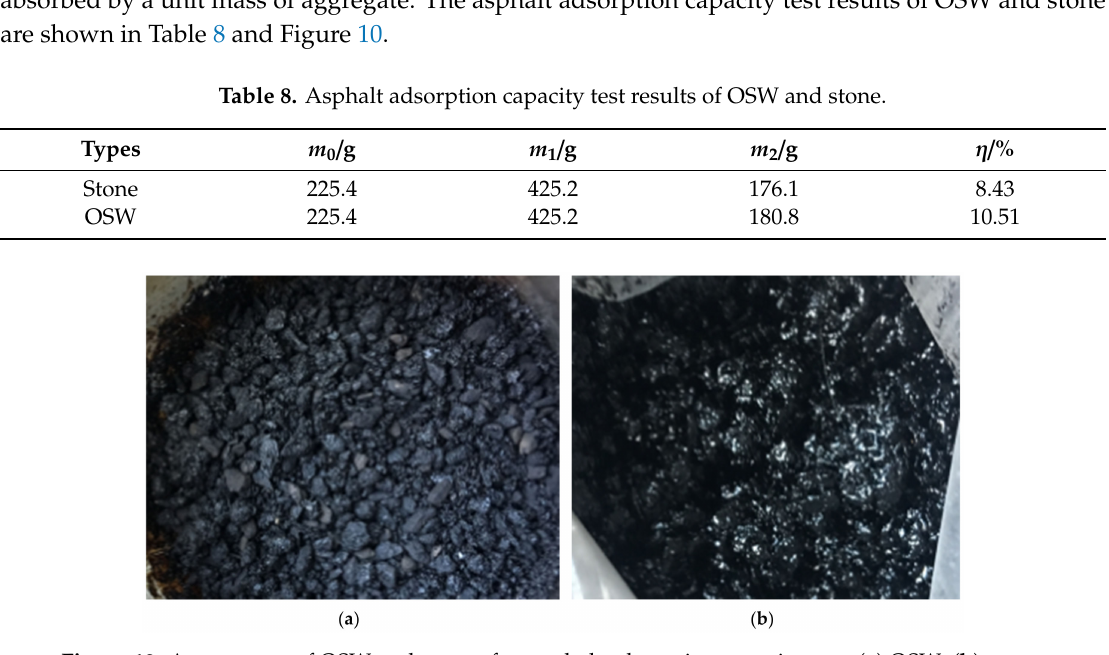
Figure 10. Appearance of OSW and stone after asphalt adsorption capacity test. ( a ) OSW; ( b )